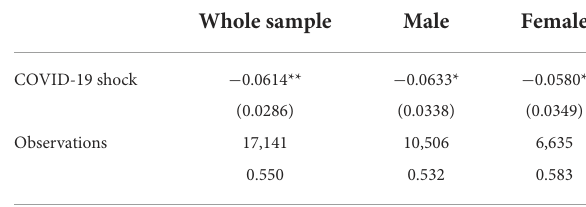
TABLE 5 Robustness test (adding the time trend term). TABLE 6 Robustness test (changing the metric of COVID-19